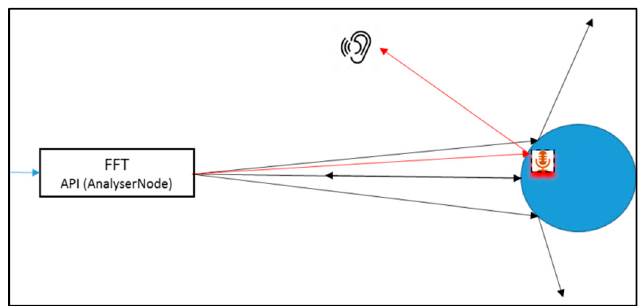
Figure 5. A hybrid model combining ray tracing and image sources method for analyzing sound in bands of frequencies.